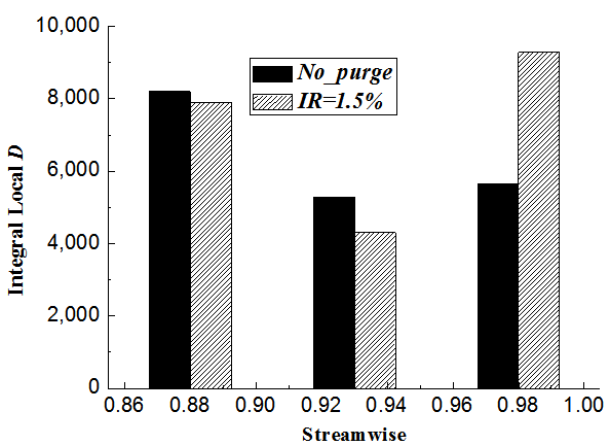
Figure 8. Dissipation coefficient integral.